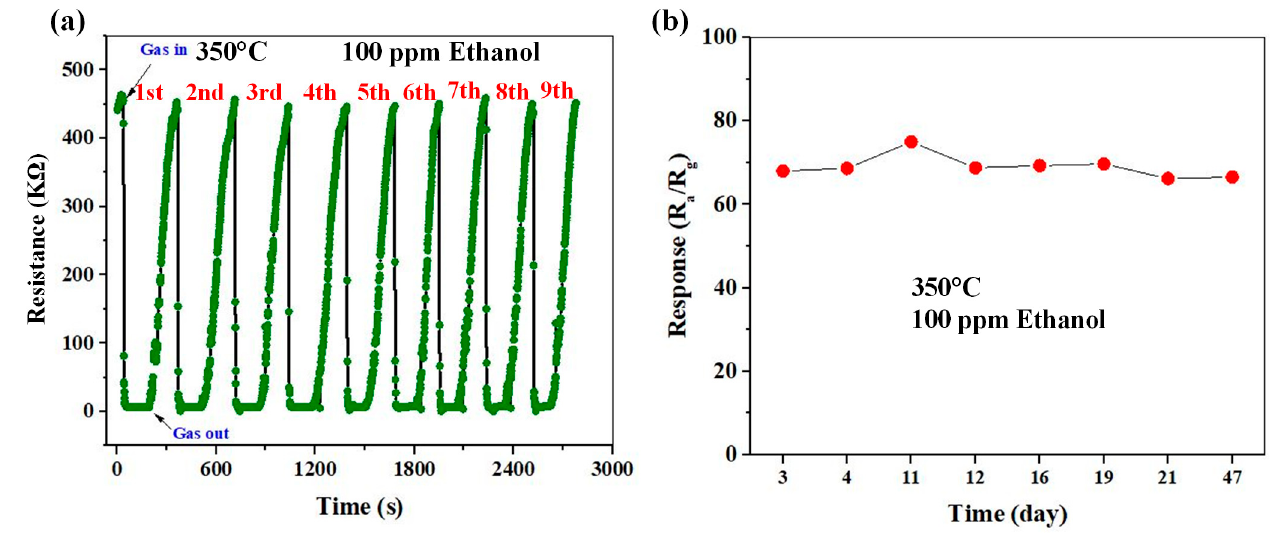
Figure 14. ( a ) Repeatability and ( b ) long-term stability of the ZC5 sensor to 100 ppm ethanol gas at 350°C. 350 ◦ C.